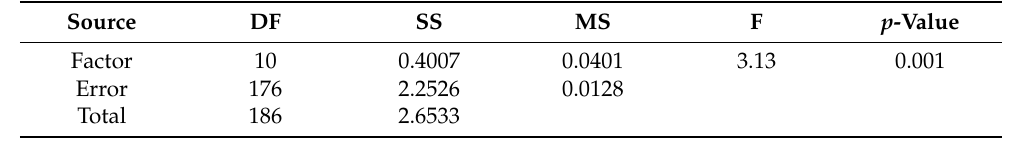
Table 4. Analysis of variance of the Thiele modulus versus the reactor radius.